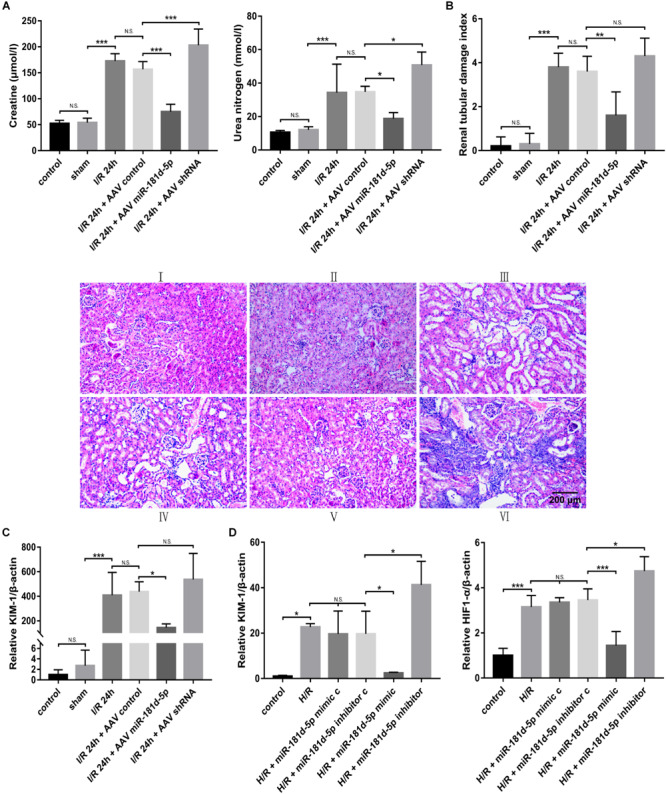
MiR-181d-5p improved kidney function in mice with renal IRI and in RTECs. C57BL/6 mice were injected with AAVs and, 3 weeks later, were subjected to 45 min of bilateral renal ischemia followed by 24 h of reperfusion. HK-2 cells were transfected with 100 nM miR-181d-5p mimic, 150 nM miR-181d-5p inhibitor or scrambled oligonucleotides and, 72 h later, were incubated in normoxia (control) or treated with hypoxia (1% oxygen) for 24 h/reoxygenation for 3 h. (A) Serum creatinine and BUN levels were assessed in mice with or without miR-181d-5p infusion after IRI (n = 6 per group). (B) Pathological score of renal tubular injury in mice infused with or without miR-181d-5p, as assessed using hematoxylin and eosin staining. Paraffin sections were stained with hematoxylin and eosin. Scale bar, 200 μm (I: control; II: sham; III: I/R; IV: I/R+AAV-control; V: I/R+AAV-miR-1818d-5p; VI: IRI+AAV-shRNA.) (C) qRT-PCR was performed for KIM-1 as described in the section “Materials and Methods.” The relative expression of KIM-1 was normalized to that of β-actin (n = 5 per group). (D) The relative mRNA expression levels of KIM-1 and HIF-1α in HK-2 cells were normalized to the β-actin expression level (n = 5 per group). The data are presented as the means ± SDs. *P < 0.05, **P < 0.01, ***P < 0.001.